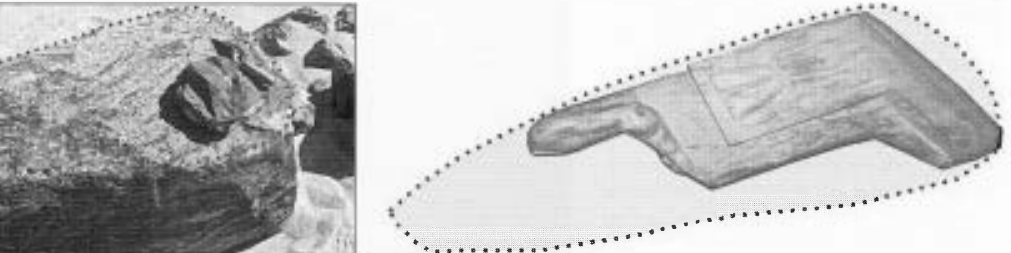
Figure 7 Chephren Gneiss block at Chephren's quarry roughly shaped into a statue (Old Kingdom) (courtesy of Tom